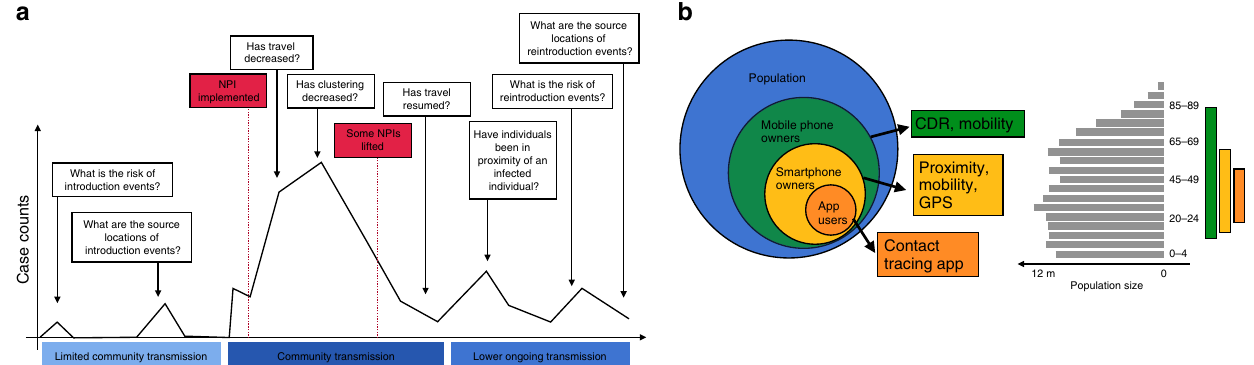
Fig. 1 The uses of mobile phone data to inform COVID-19 public health response and their possible biases. a Over the course of the epidemic, mobile phone data and applications may be relevant to help answer a number of important epidemiological questions needed to guide the implementation and evaluation of various interventions. b However, these data should be considered in light of ownership and use biases that may or may not limit generalizability to the overall population. Mobile phone owners and users only represent a subset of the population and may have additional age (shown here for a synthetic population for illustrative purposes), socio-demographic, or geographic biases. Applications that require the use of a smartphone or application may further limit the generalizability of these data since they represent smaller subsets of the user